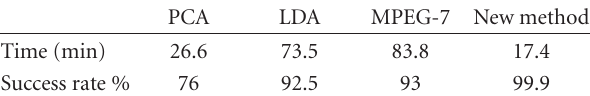
Table 12: The time consumed (in minutes) and the success recognition rate for the di ff erent methods using the xm2vts (C2) database.